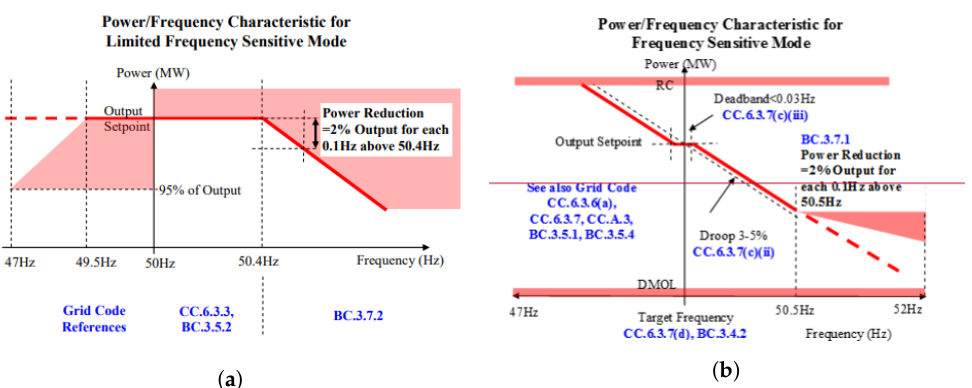
Figure 1. ( a ) The limited sensitivity mode of droop control from [12]. ( b ) Sensitive mode of droop control from